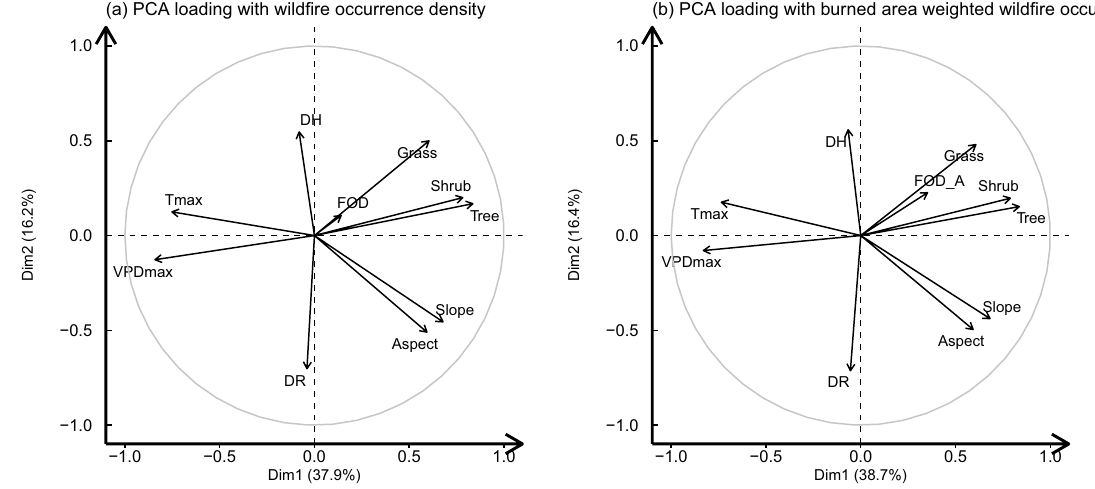
Figure 9. PCA loading plots with ( a ) fire occurrence density, ( b ) burned area weighted fire occurrence density. The variables include distance to road (DR), housing density (DH), aspect, slope, tree, shrub, grass, maximum